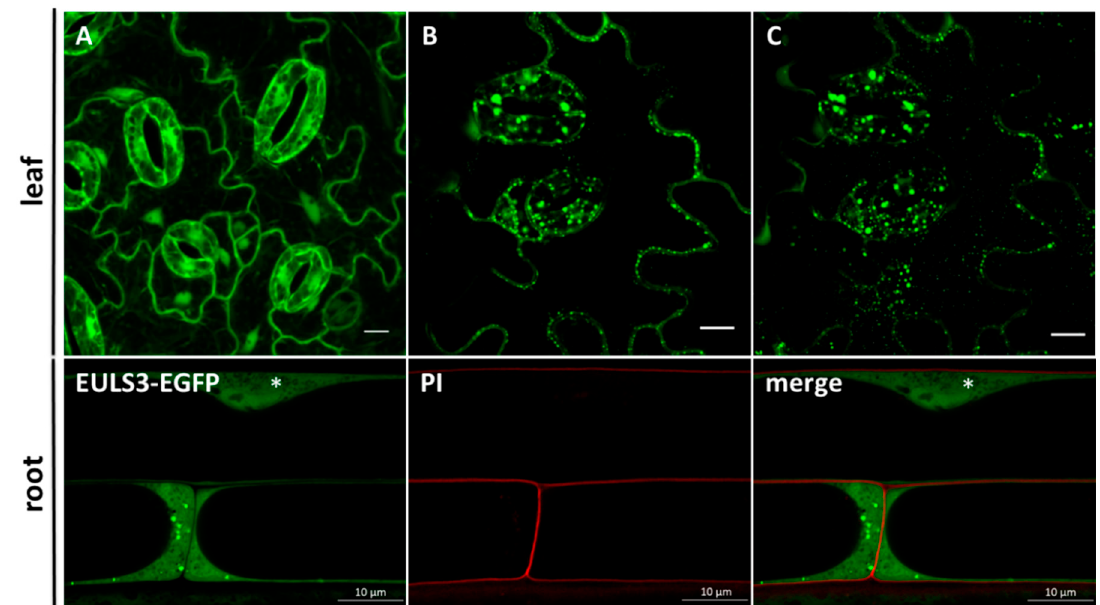
Figure 1. Localization of ArathEULS3-EGFP in Arabidopsis thaliana . ( A – C ) Confocal images representing unstressed Arabidopsis epidermal leaf cells. Panels A and C show a compilation of fluorescent images acquired along the z-axis. Panel B represents single slice optical sections. The lower panel represents ArathEULS3-EGFP localization in A. thaliana roots. The asterisks indicate the position of the nucleus. Confocal images are single slice optical sections. PI (propidium iodide) and EGFP channels are combined in the overlay picture (merge). Scale bars represent 10 µ